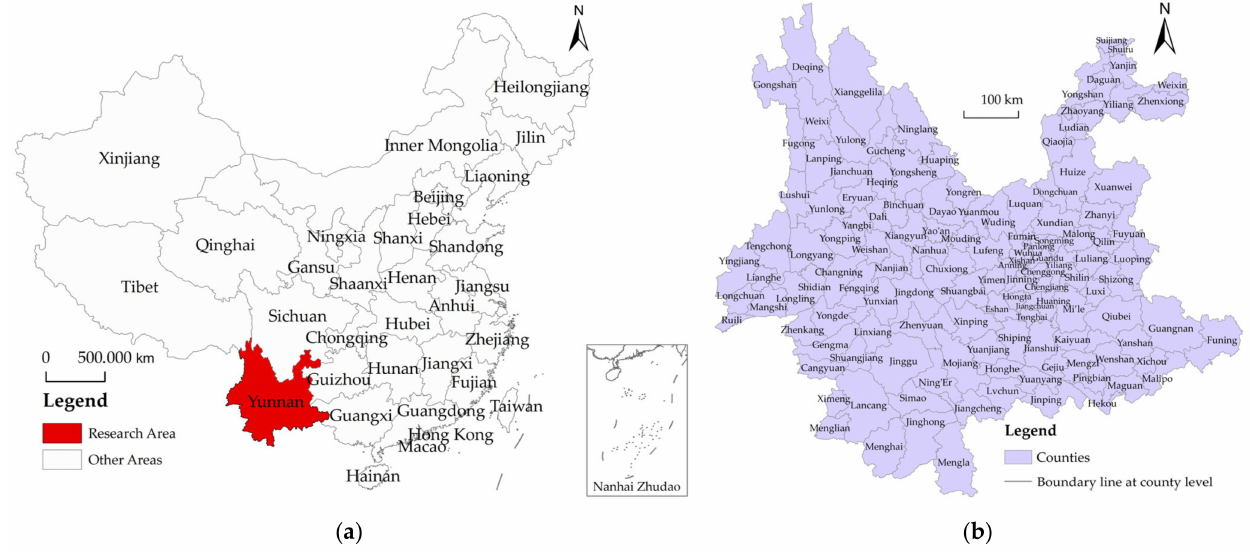
Figure 1. Geographic location of the study Aaea. ( a ) Location of Yunnan Province in China; ( b ) distribution of 129 counties in Yunnan